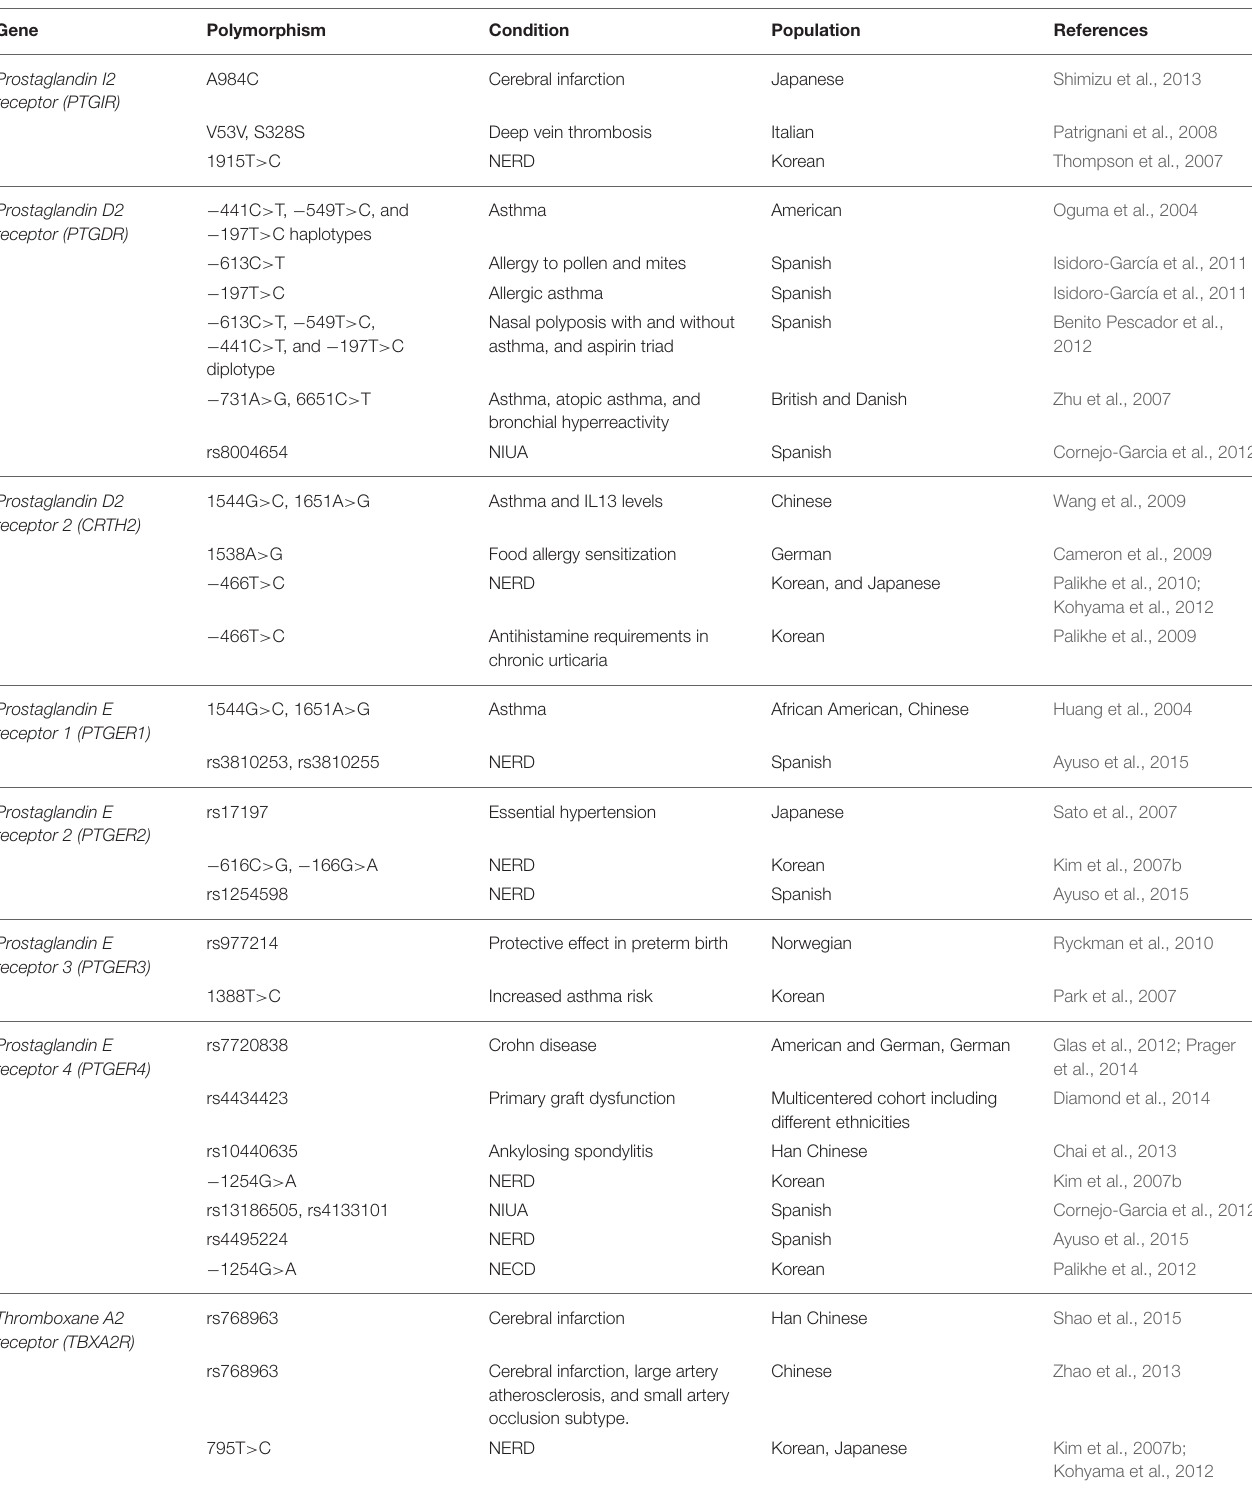
TABLE 1 | Main prostaglandin and leukotriene polymorphisms associated with different human inflammatory